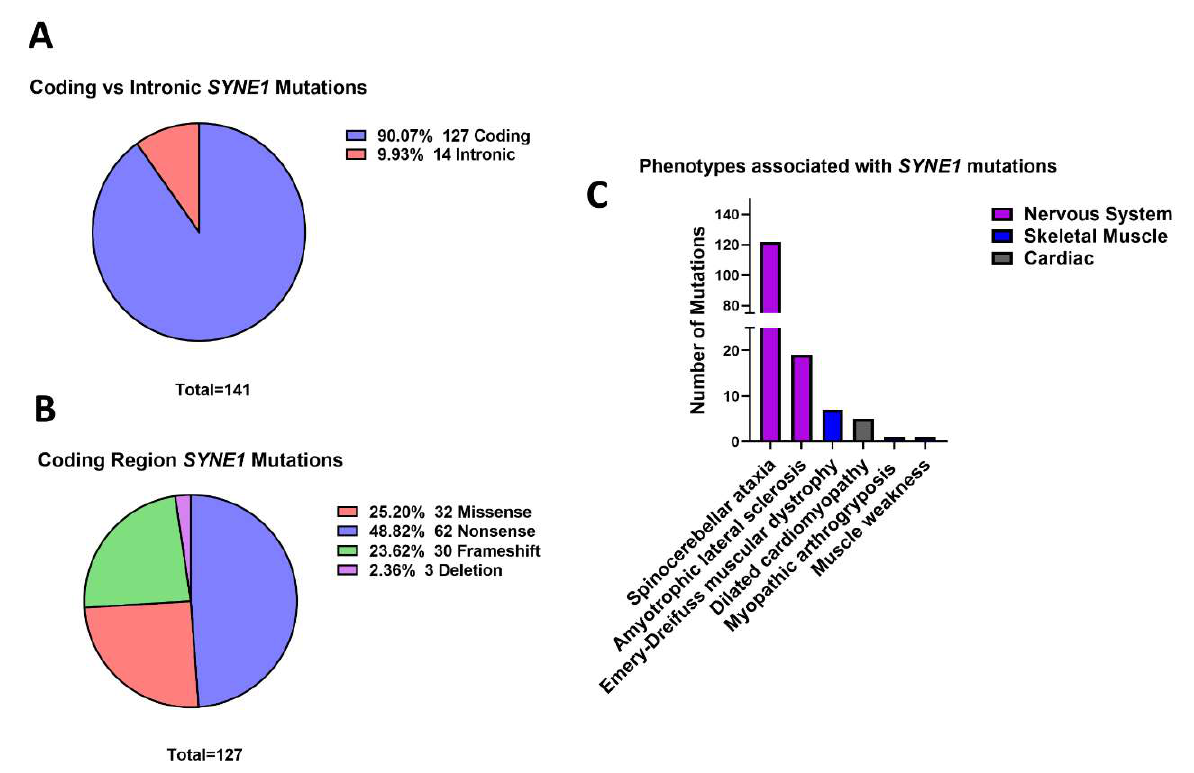
Figure 6. SYNE1 mutations. ( A ) Coding vs. intronic mutations. There were 127 (90.07%) mutations identified in the coding region of SYNE1 and 14 (9.93%) were intronic. ( B ) Coding region mutations. Almost half (48.82%, 62) of coding region mutations were nonsense. Many mutations were also missense (32, 25.20%) and frameshift (30, 23.62%) variants. Three (2.36%) deletion mutations were also identified. ( C ) Diseases associated with SYNE1 variants. The most common disease resulting from SYNE1 variants was autosomal recessive spinocerebellar ataxia (SCAR8). 122 (85.82%) mutations were related to this disease. Amyotrophic lateral sclerosis was also found to be frequently caused by SYNE1 mutations (19, 13.48%). Seven cases of Emery-Dreifuss muscular dystrophy (EDMD) were related to SYNE1 variants, and a handful of mutations were associated with myopathic arthrogryposis (2), dilated cardiomyopathy (DCM) (5) and general muscle weakness (1). Created with GraphPad